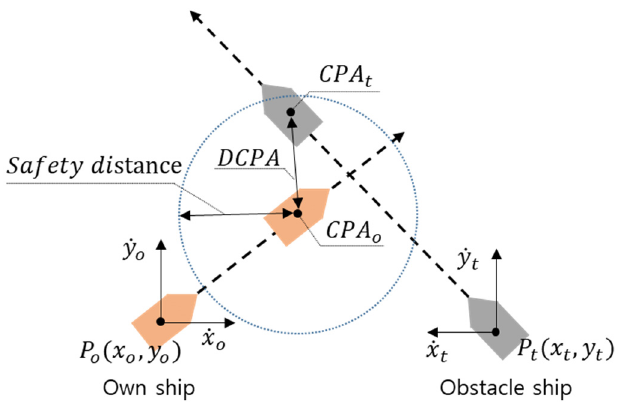
Figure 4. Typical vessel interaction. The composition and meaning of the picture are similar.to [13].